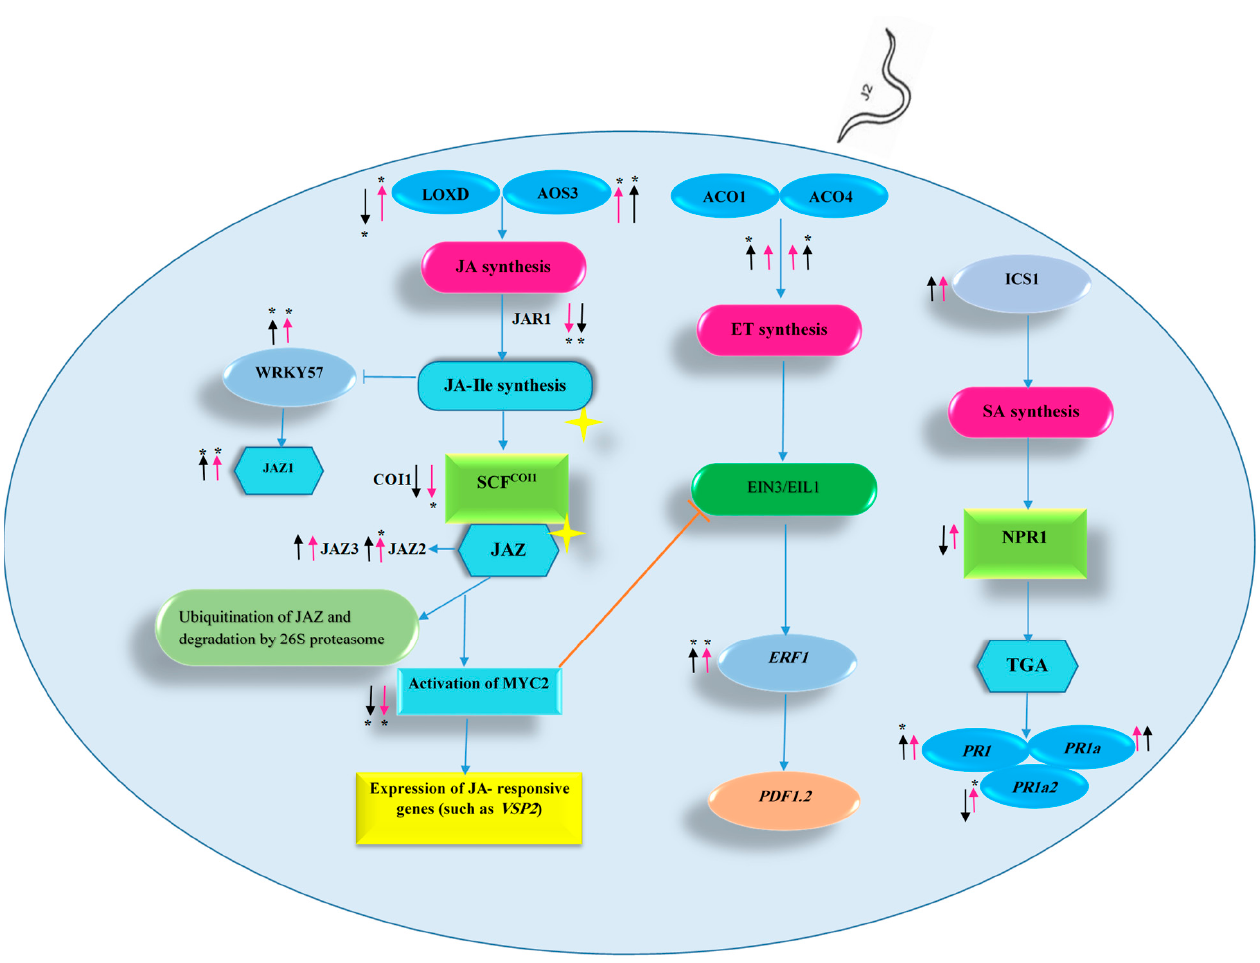
Figure 6. Model depicting the changes in the expression of genes related to the ethylene (ET), salicylic acid (SA), and jasmonic acid (JA) pathways in the roots of Dutch Mobil and ALYSTE F-1 (as highly susceptible and moderately resistant tomato cultivars, respectively) at 14 days after inoculation (DAI) with Meloidogyne javanica . The mRNA transcripts of genes related to the JA pathway in the two cultivars demonstrated decreased expression of JA-responsive genes. The transcription factor (TF) WRKY57, as a negative regulator of JA signaling, enhanced the expression level of SlJAZ1 . Most of the genes related to the ET pathway in ALYSTE F-1 were more strongly expressed than in Dutch Mobil. Although. There was no significant change in the expression of genes related to SA synthesis and signaling in the two cultivars; ALYSTE F-1 showed constitutively higher levels of these genes. The ET and JA pathways acted antagonistically at 14 DAI. It is possible that the downregulation of SlMYC2 decreased the inhibitory effect on the EIN3/EIL1 TFs and led to the upregulation of SlERF1 and other ERFs. The pink and black arrows show a decrease or increase in the expression of genes in Dutch Mobil and ALYSTE F-1, respectively. The asterisks on each arrow indicate significant differential expression ( p ≤ 5%) compared to uninfected plants. JA: jasmonic acid, ET: ethylene, SA: